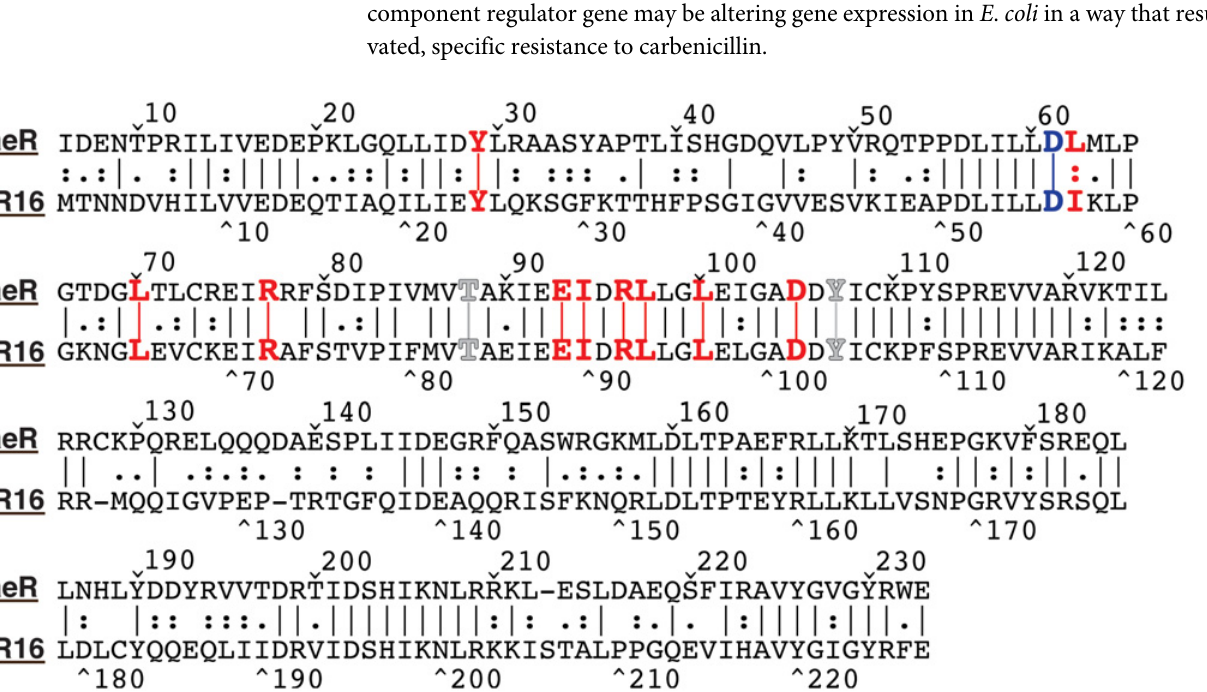
Fig 2. Amino acid alignment of the BaeR response regulator of E . coli and the response regulator from β LR16. Alignment was performed with MegAlign from the Lasergene software package from DNASTAR (Madison, WI) using the Lipman-Pearson alignment tool (Ktuple:2; Gap Penalty: 4; Gap Length Penalty: 12). Levels of similarity between the sequences are indicated as lines (identical) or dots (similar). The conserved aspartate residue that is phosphorylated is indicated in blue (Asp 56 in β LR16). Switch residues are indicated in gray (Thr 83 and Tyr 102 in β LR16), and amino acids from BaeR involved in domain swap interactions, and their β LR16 counterparts, are shown in